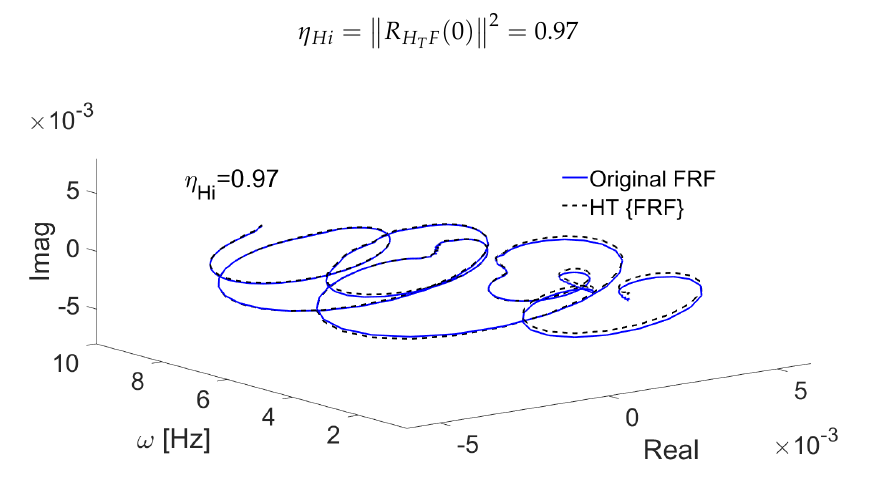
Figure 5. Experimental FRF of the six-story building-like structure in blue line and its corresponding Hilbert transformation in dotted black